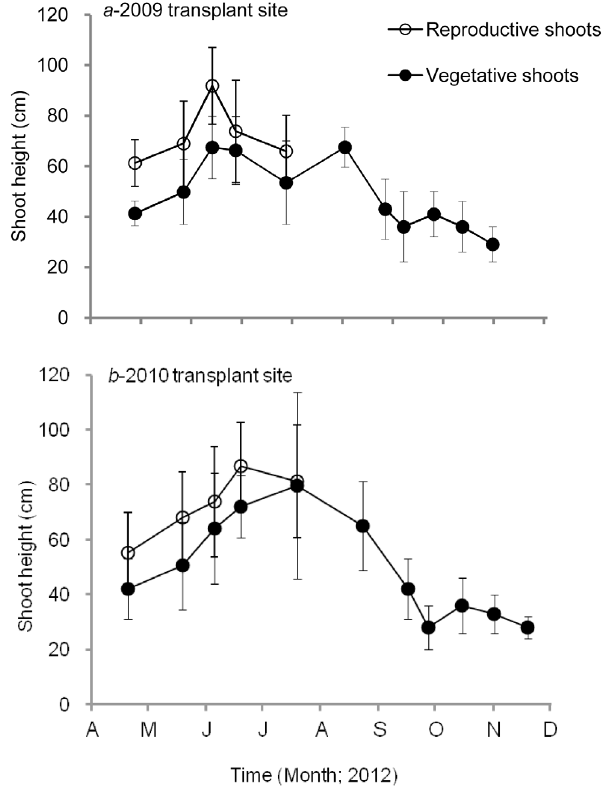
Figure 3. Variations in shoot height (cm) of Zosteramarina at N the 2009 ( a ) and 2010 ( b ) transplant sites. # , reproductive shoots; , vegetative shoots. Values are means 6 SD.